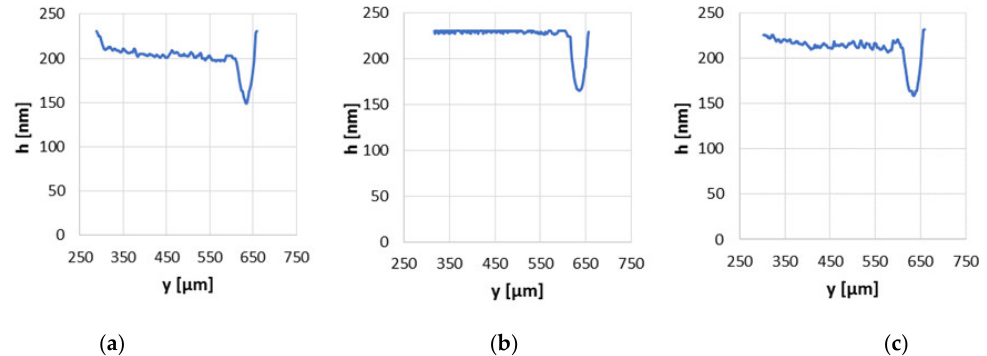
Figure 10. Oil film thickness distribution graphs in non-conformal contact with load of 20 N and sliding velocity of 0.2 m/s for the base surface ( a ), modified surfaces no. 2 ( b ) and no. 3 ( c ).